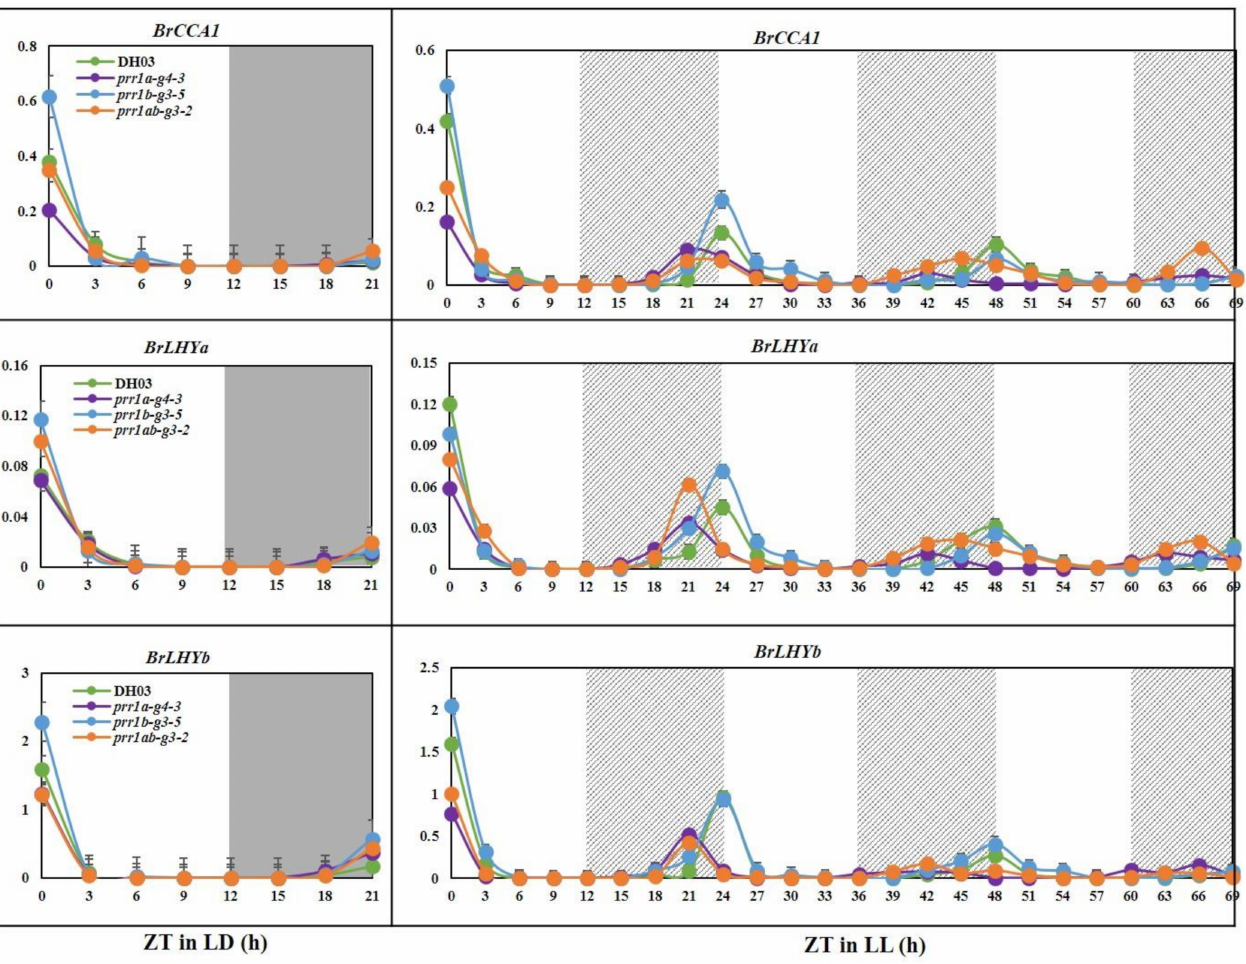
Figure 7. Expression of BrCCA1 and BrLHYa and b under different light regimens. The leaves of 2-week-old plants grown in soil were harvested at the indicated times for total RNA extraction and qRT-PCR analysis. Data are the mean ± SD of three biological replicates. Diurnal rhythm of BrCCA1 and BrLH Ya and b mRNA abundance under LD (16 h/8 h) conditions. Circadian rhythm of the mRNA expression of BrCCA1 and BrLHYa and b in plants grown under LD conditions and transferred to constant light (LL). Time is presented as Zeitgeber time (ZT), in which the dark to light transition is defined as ZT0. Gray regions indicate nighttime. Shaded regions indicate subjective night, defined by the entraining light/dark